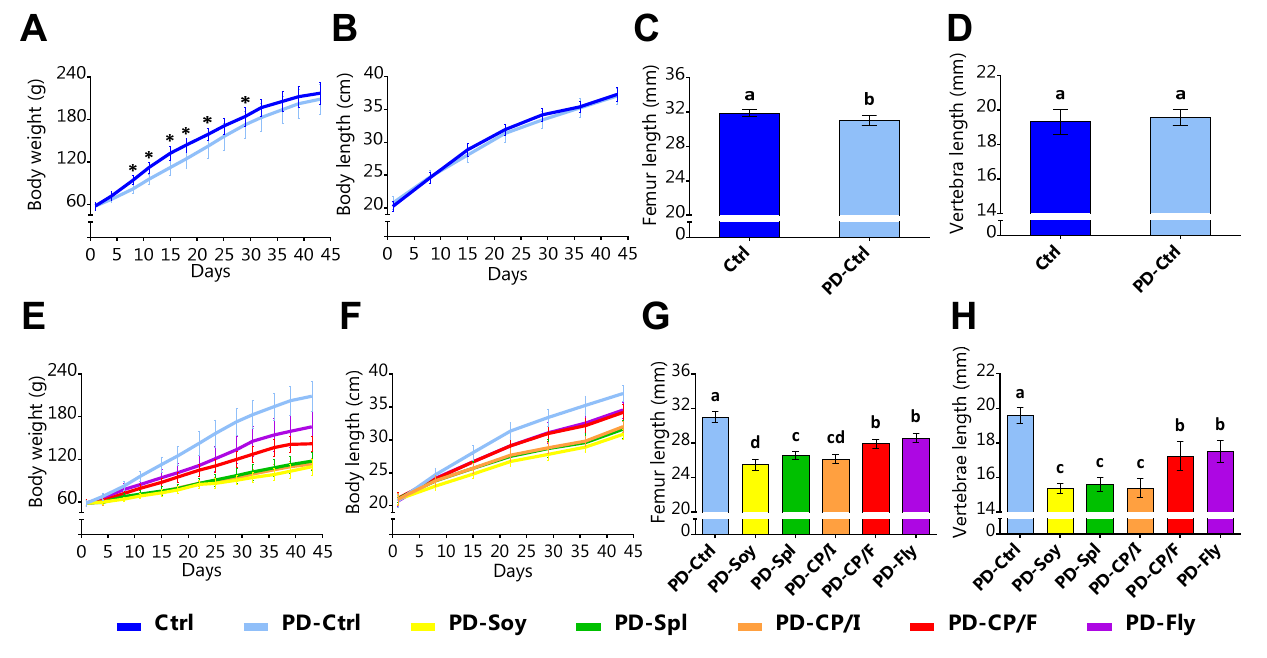
Figure 1. Growth patterns. ( A ) Ctrl groups’ body weight (g) throughout the experiment. ( B ) Ctrl groups’ body length (cm) throughout the experiment. ( C ) Ctrl groups’ right femur length measured by micro-CT (mm). ( D ) Ctrl groups’ 3rd–5th lumbar vertebra length measured by micro-CT (mm). ( E ) PD groups’ body weight (g) throughout the experiment. ( F ) PD groups’ body length (cm) throughout the experiment. ( G ) PD groups’ right femur length measured by micro-CT (mm). ( H ) PD groups’ 3rd–5th lumbar vertebra length measured by micro-CT (mm). Values are expressed as mean ± SD of n = 8 rats/group, different superscript letters are significantly different ( p < 0.05) by one-way ANOVA followed by Tukey’s test.